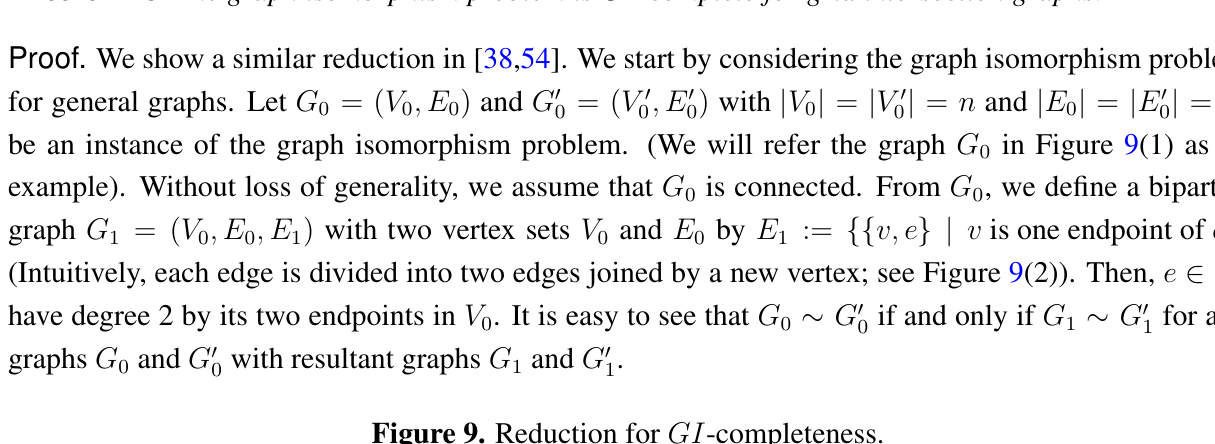
Figure 9. Reduction for GI